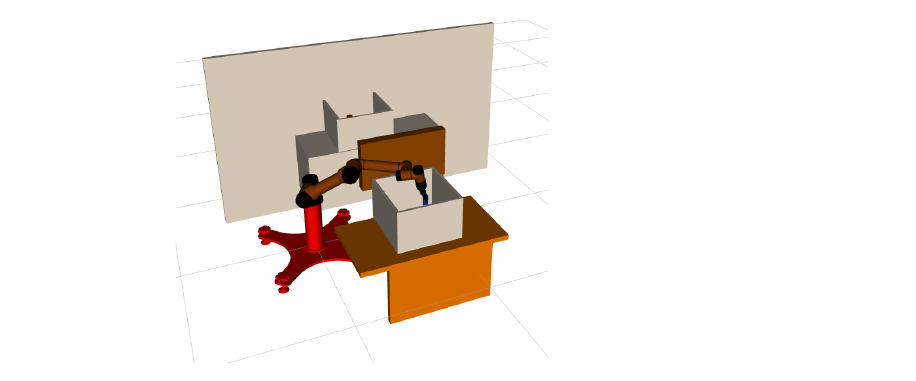
Figure 12. The starting position of AUBO − i5 when it is about to perform picking task.